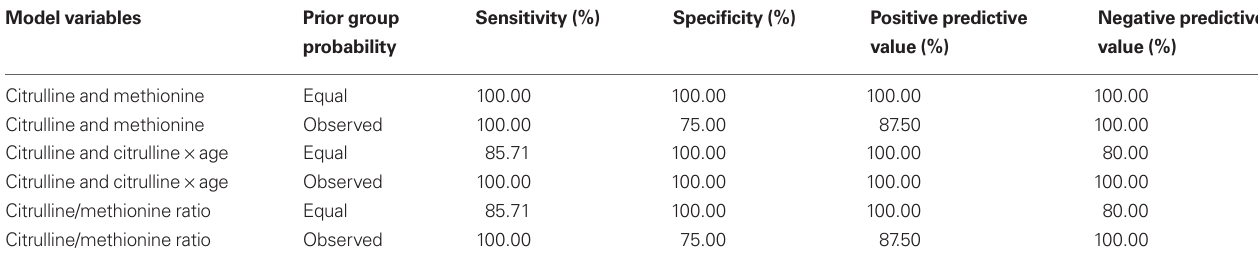
Table 2 | Performance statistics for discriminant